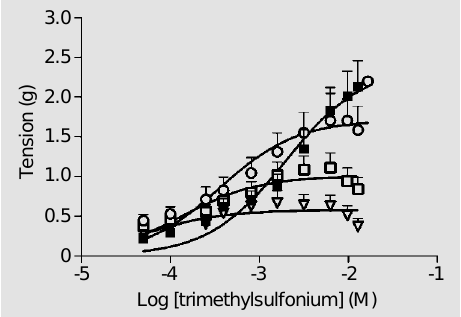
Figure 1. Inhibition of specific [ 3 H]-quinuclidinyl benzilate (QNB) binding to membranes isolated from rat cortex by atropine (filled squares, N = 8) or trimethylsulfo- nium (open squares, N = 8). Membranes were incubated with [ 3 H]-QNB and unlabeled com- pounds for 1 h at room tempera- ture in Na + /K + phosphate buffer. Specific binding was calculated by subtracting the nonspecific binding measured in the pres- ence of 2 mM atropine from total binding (T). Data are reported as means ± SEM.